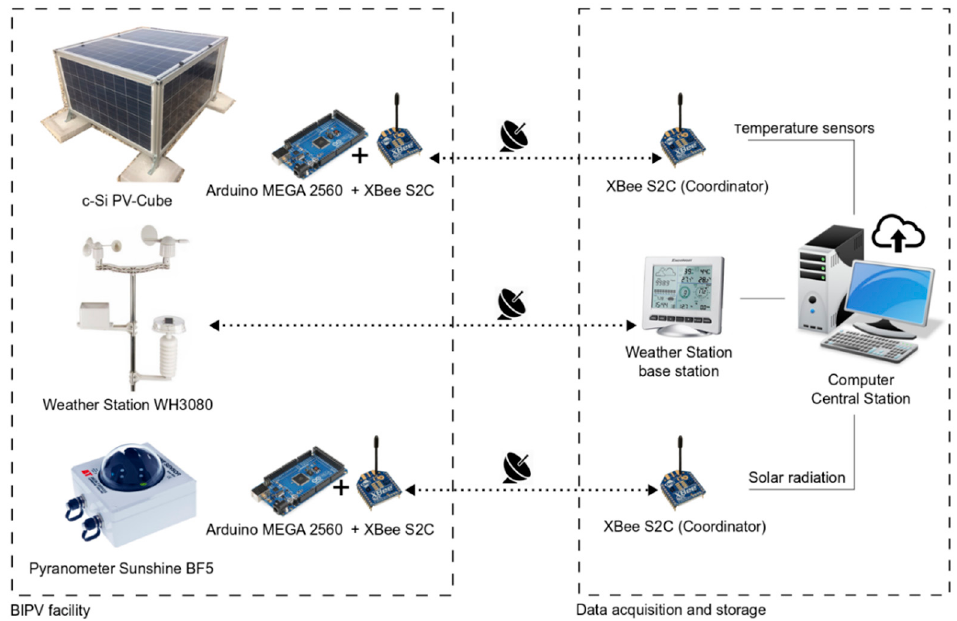
Figure 2. Basic architecture of the monitoring system using a wireless sensor network with the ZigBee protocol for the building-integrated photovoltaic (BIPV) “PVCube” facility (rooftop), which radio-transmits data to a laboratory in the lower floor. Table 1. Technical specification of the monitoring system for the BIPV facility.